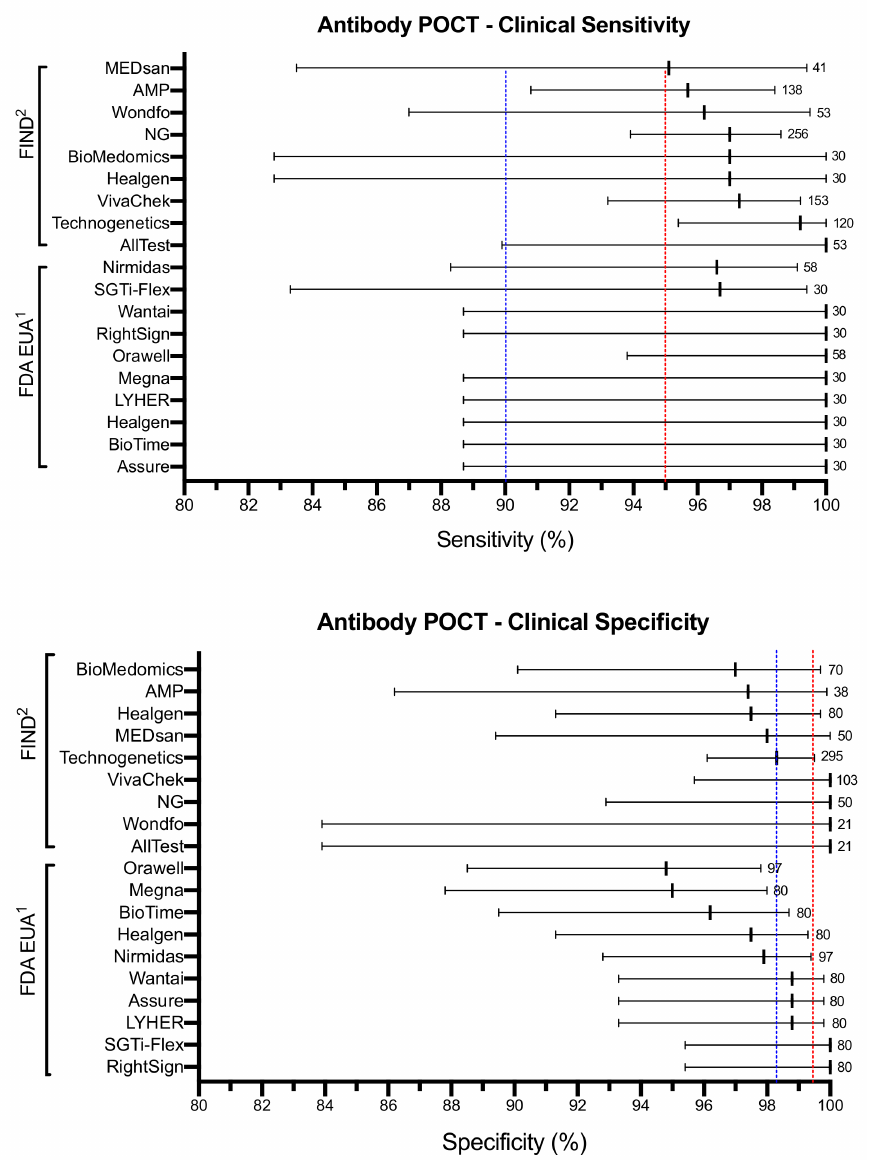
Figure 5. Clinical sensitivity and specificity of indirect POCTs. Selected antibody POCTs that met Table 2. infection) “desirable” clinical sensitivity cut-off. Short vertical lines represent the calculated clinical sensitivity (top panel) and clinical specificity (bottom panel) values. Horizontal bars represent lower and upper 95% confidence intervals. Blue and red lines represent the WHO TPP “acceptable” and “desirable” thresholds, respectively. Numbers represent total positive (sensitivity) and negative (specificity) clinical samples tested. All reported values were obtained from FDA, FIND, or manufacturer’s instruction for use (IFU) and have not been validated by our group. 1 Performance data based on manufacturer’s claims reported in FDA EUA database. 2 Performance data based on independent evaluation tests reported in FIND